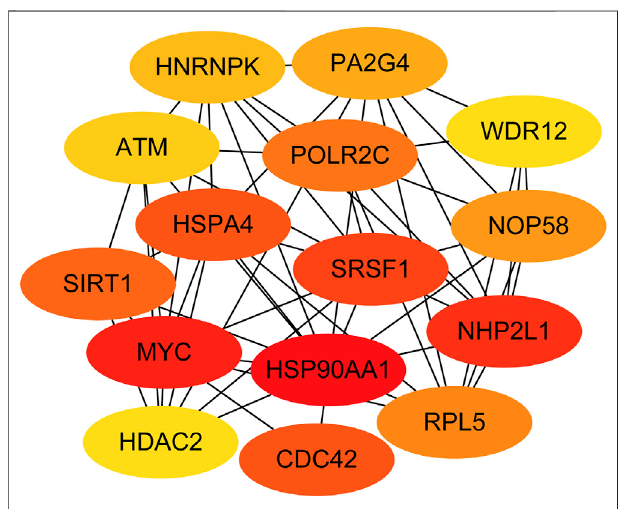
FIGURE 5 | Identi fi cation of the top 15 genes from the protein – protein interaction (PPI) network of the three